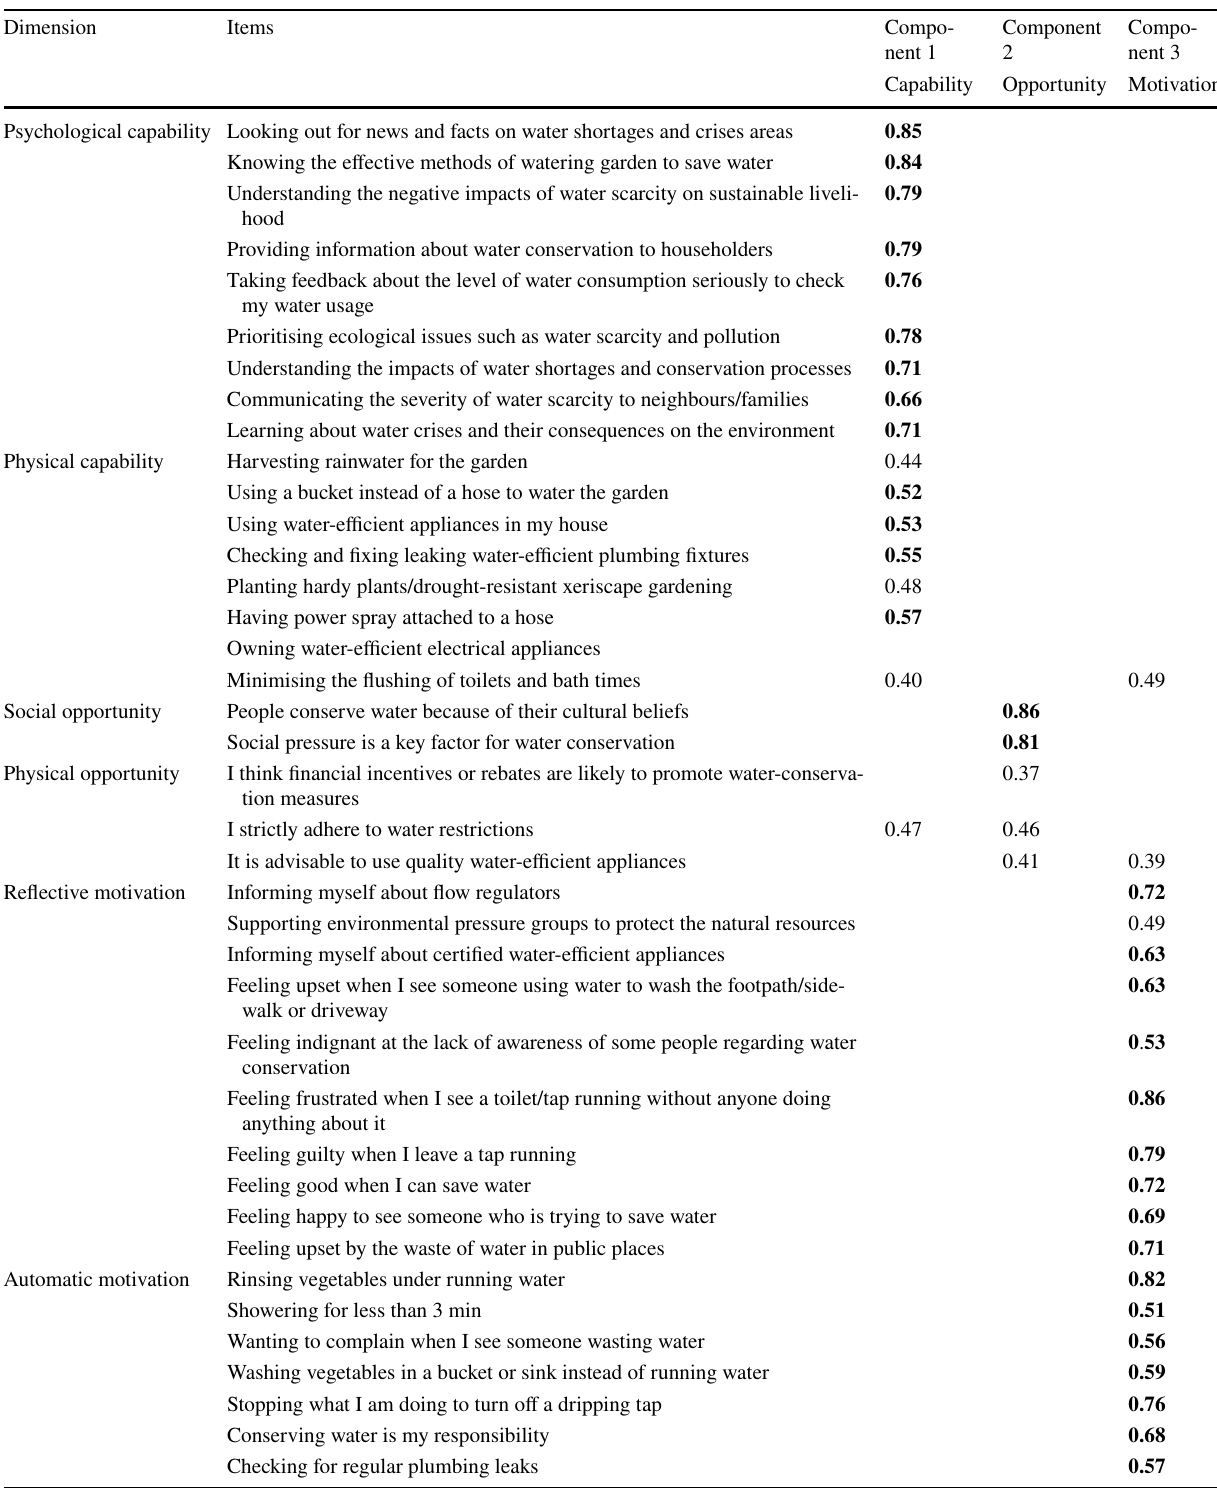
Table 1 Factor loadings of psychological–social constructs of water conservation into the COM-B